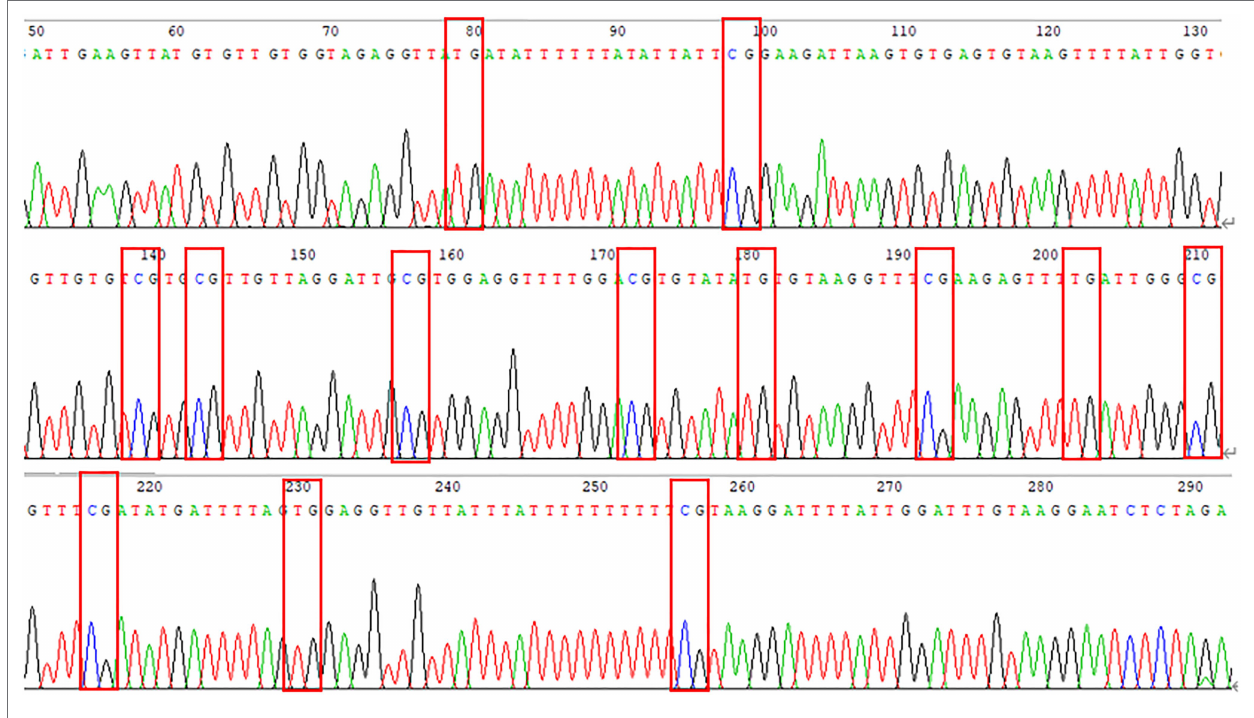
FIGURE 6 | Peak sequencing of methylated region of WNT2 gene.